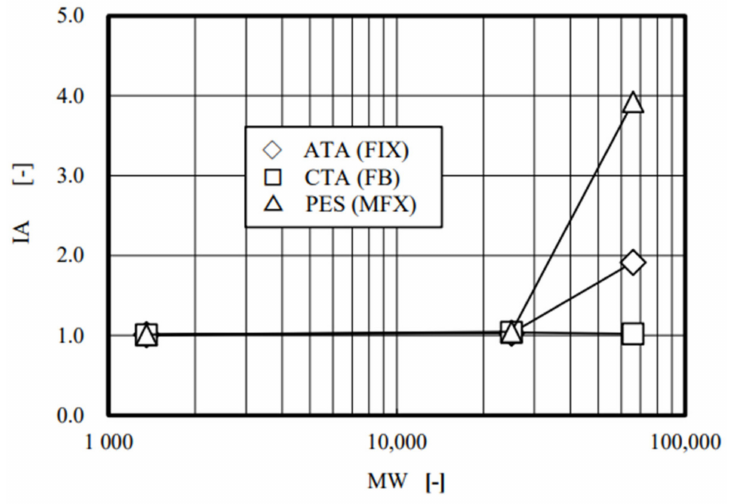
Figure 6. Relationship between the index for asymmetricity (IA) and molecular weight of the solute (MW).